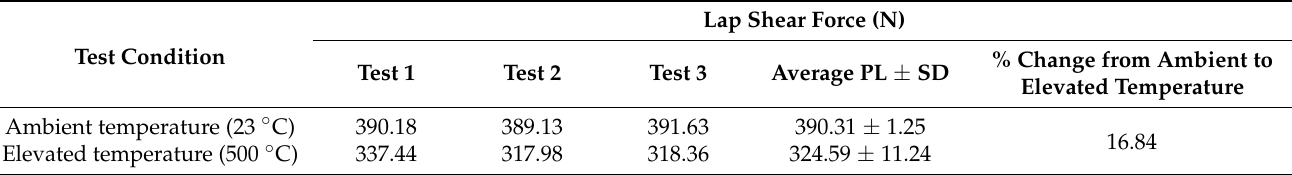
Figure 10. Laser weld with ( a ) 4 spots and ( b ) 6 spots. Load vs. extension plot of lap shear test at 500 °C temperature for ( c ) 4-spot and ( d ) 6-spot laser welds. Table 7. Lap shear test at normal and elevated temperature.